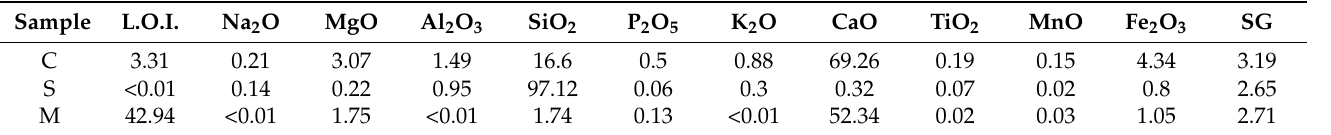
Table 4. Chemical compositions (wt.%) and specific gravity of the selected materials used in the production of the specimens.